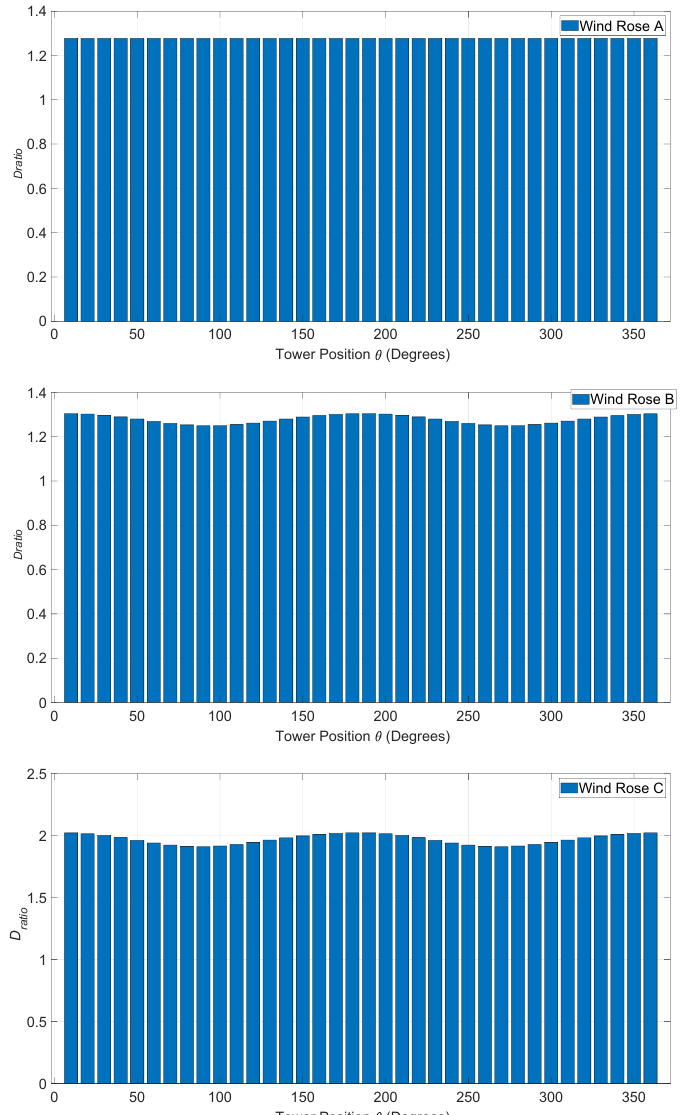
Figure 22. Absolute D Ratio between uni-directional fatigue damage and fatigue damage at a range of tower positions θ for a range of wind